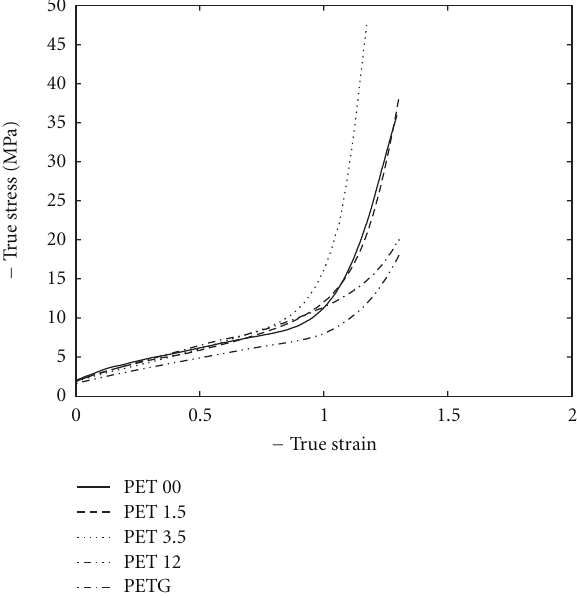
Figure 1: Material comparison, uniaxial compression at 90 ◦ C and 0.1/s.